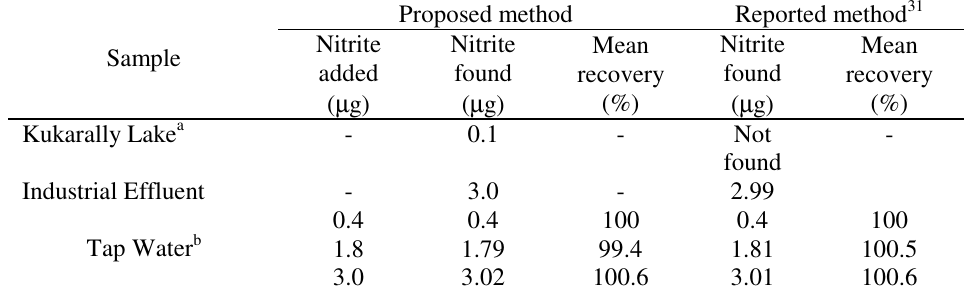
Table 2. Determination of Nitrite in Polluted Water and Tap